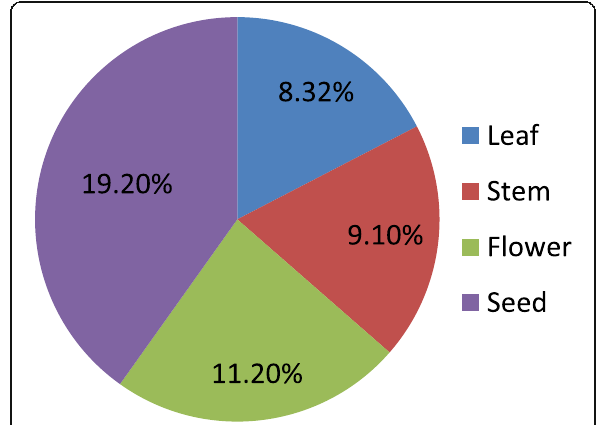
Fig. 1 Protein percentage of different parts of Cassia sophera L